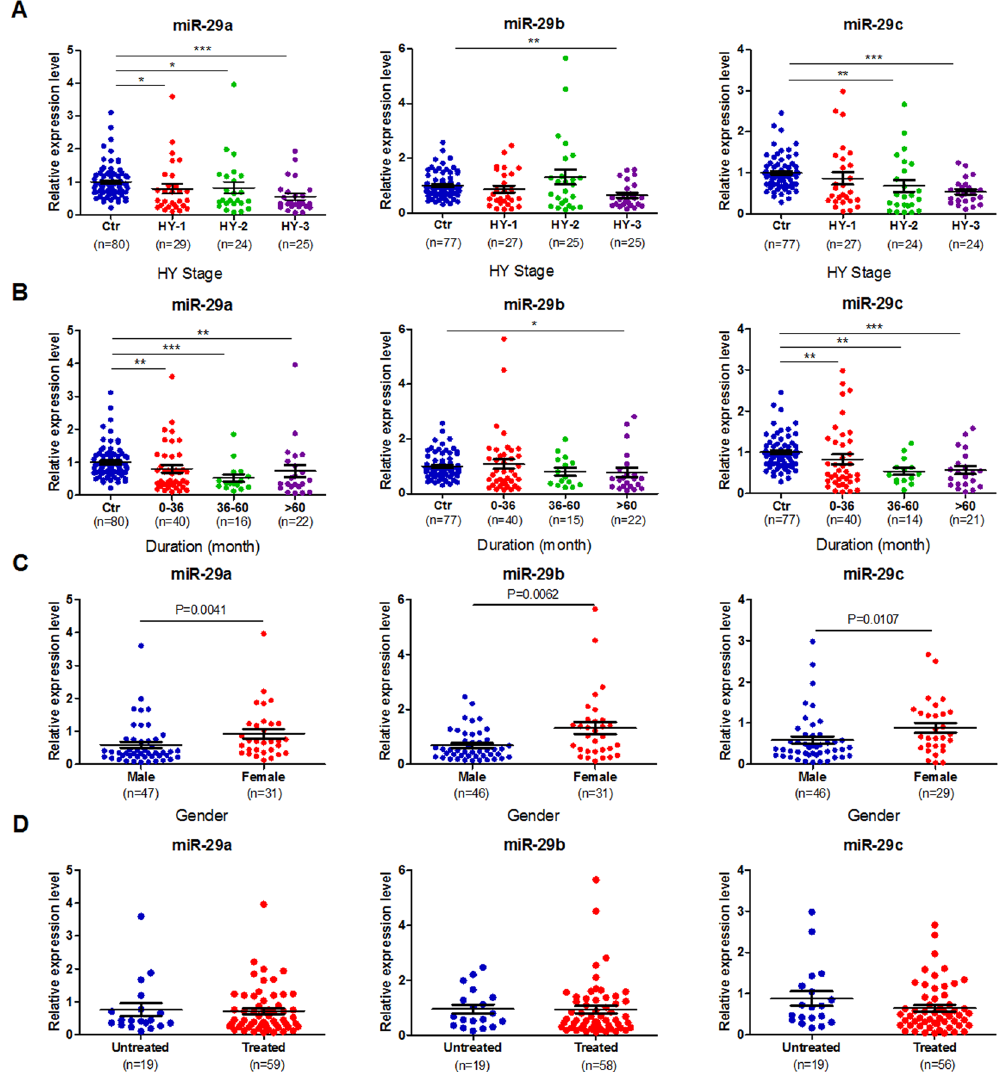
Figure 2. The expression levels of miR-29s in the serum of control subjects and patients with PD based on Hoehn & Yahr stages ( A ), disease duration ( B ), gender ( C ) and the expression levels of miR-29s in the serum of L-dopa-naïve PD patients and L-dopa-treated PD patients ( D ). Data are presented as the means ± SEM. Differences were analyzed by Kruskal-Wallis test in A and B or Mann-Whitney test in C and D. * p < 0.05, ** p < 0.01 and *** p <